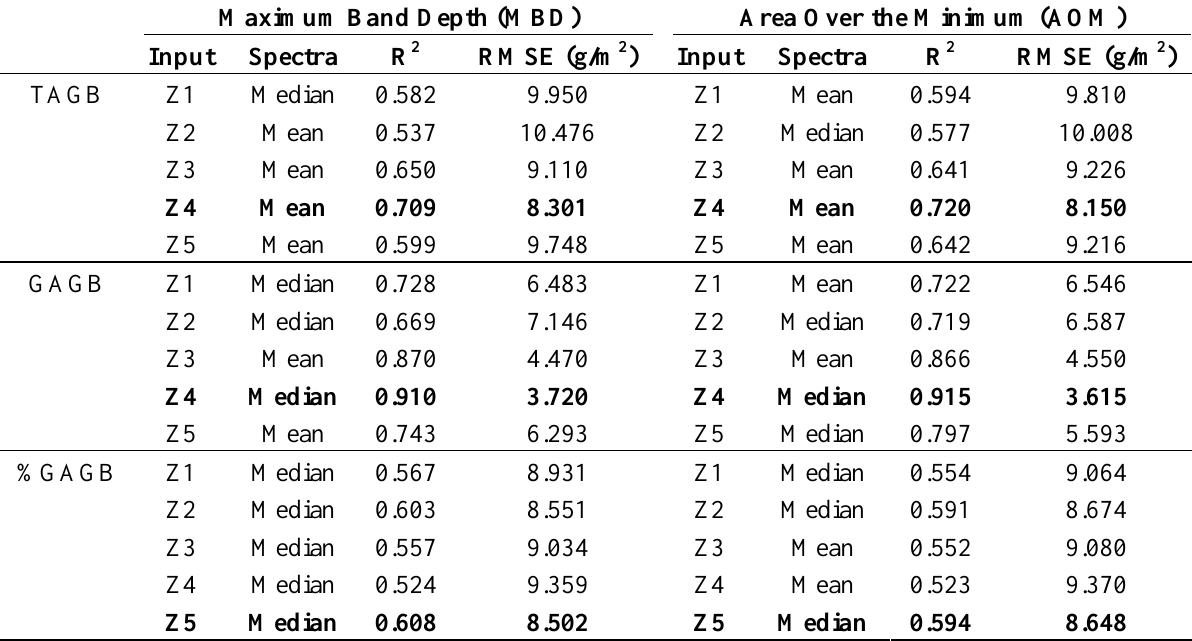
Table 7. Performance of Ordinary Least Squares Regression (OLSR), for predicting total (TAGB), green (GAGB) and percentage of green (%GAGB) grass/clover biomass using indices derived from the continuum removed spectra. In bold: most accurate